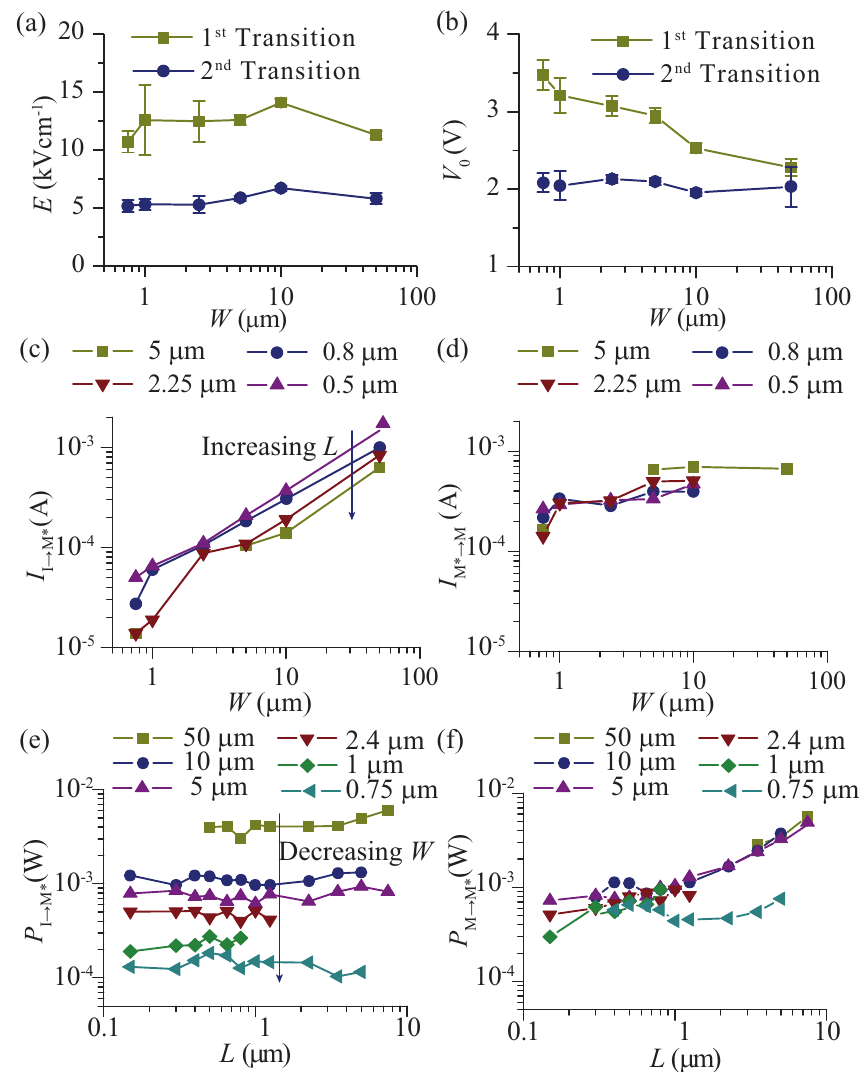
Figure 4. ( a ) The “average” electric field and ( b ) the transition voltage offset for both transitions vs . W . The transition currents for the ( c ) first and ( d ) second transitions as a function of W for several values of L . The dissipated power density for the ( e ) first and ( f ) second transitions as a function L for several values of W